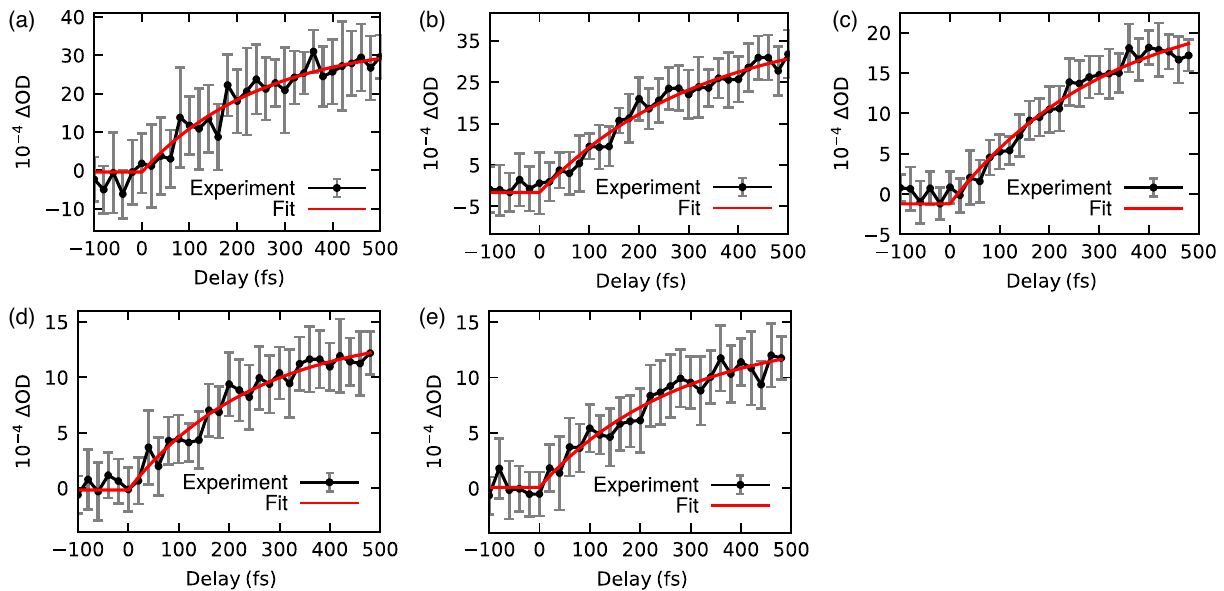
FIG. 10. Exponential fits (red lines) of the transient absorption scans for different energy regions on the ps timescale. The black points and the gray markers correspond to the measured change in optical density and to their standard error, respectively. The labels (a) to (e) correspond to different energy regions as indicated in Table II.